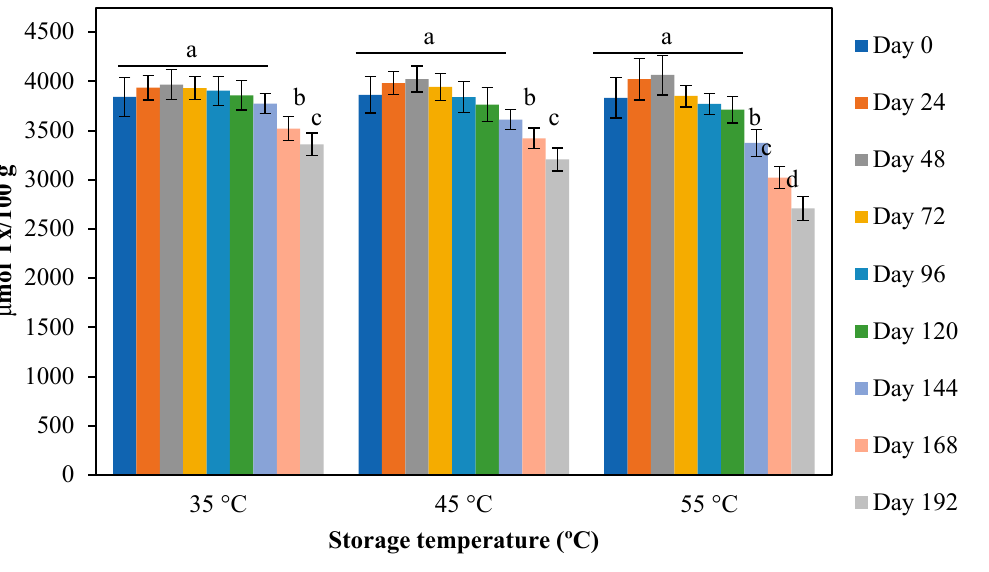
Figure 12. Effect of storage time at different temperatures on the antioxidant capacity measured using FRAP of H. macrocarpa and nanocellulose powder. Bars with different letters (a to d) for the each temperature treatment, are significantly different ( p < 0.05).